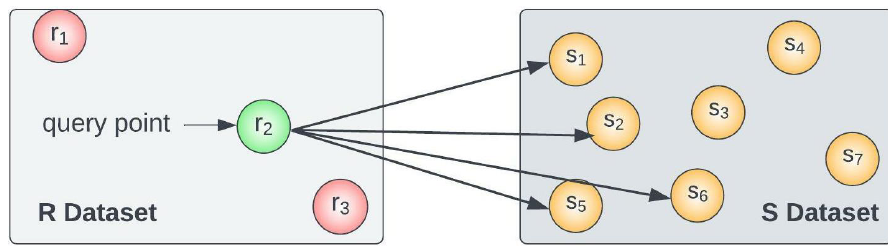
Figure 1. An example of kNN Search with k = 4.